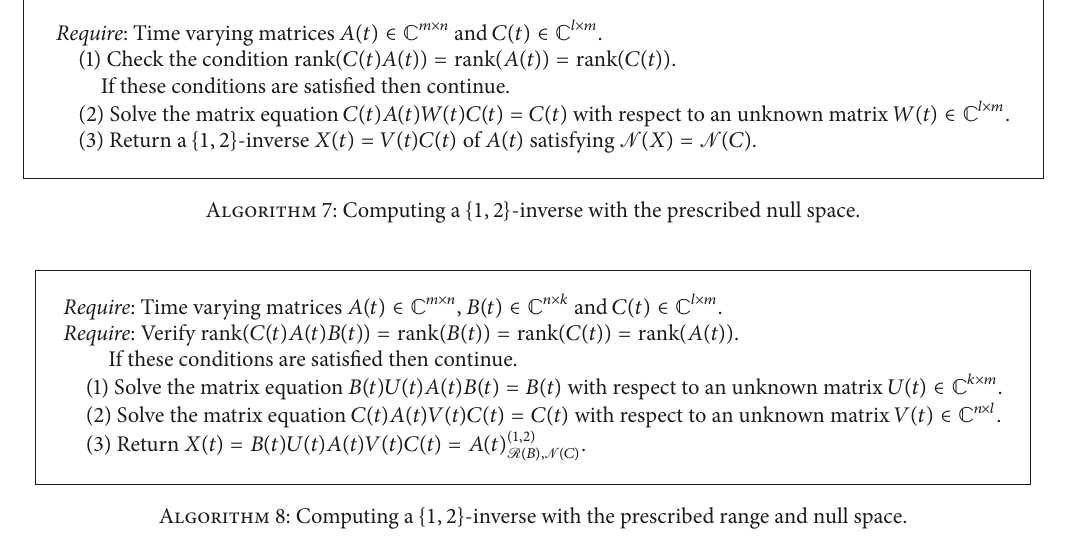
Algorithm 8: Computing a {1,2} -inverse with the prescribed range and null